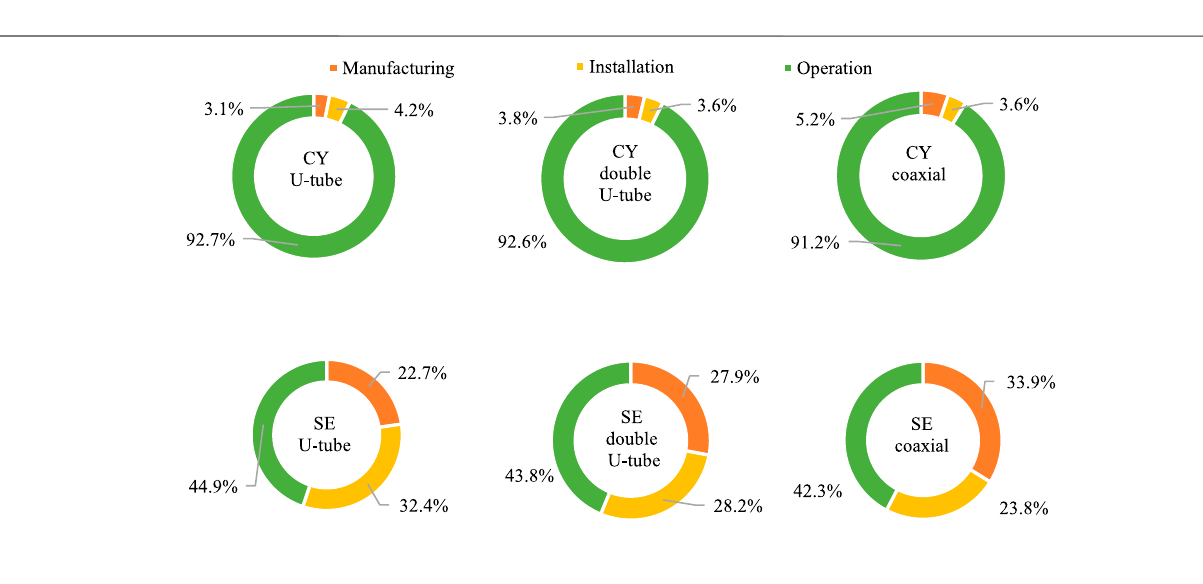
Frontiers in Built Environment |